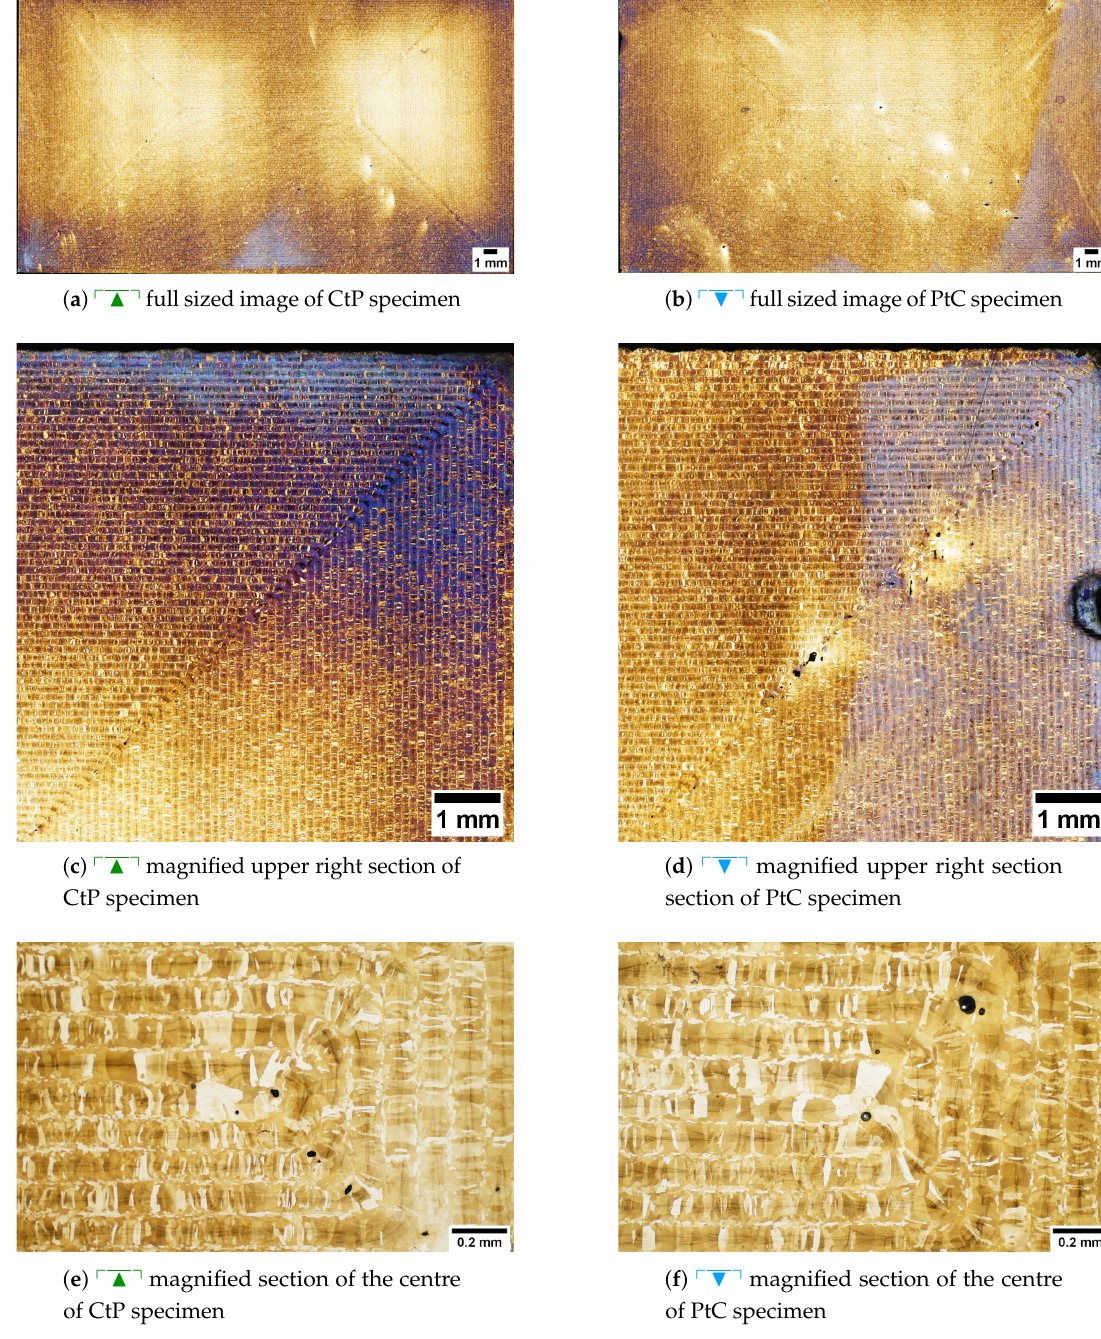
Figure 7. Optical microscopy images of the samples’ bottom surface after polishing and